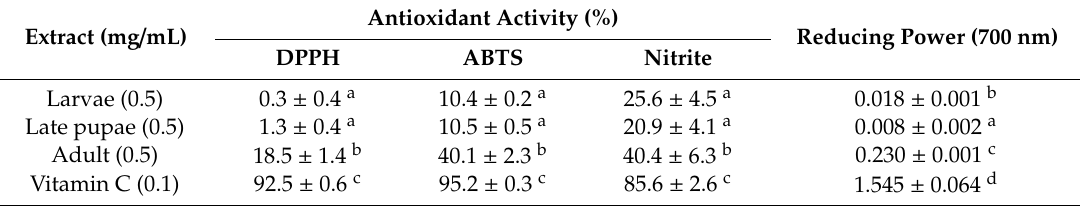
Table 4. Antioxidant activities of ethanol extracts of Buckfast honey bee drone larvae, pupae and adults from Denmark. The concentration used for 1,1-diphenyl-2-picryl hydrazyl (DPPH), 2,2-azobis (3-ethylbenzothiazoline-6-sulfonate (ABTS), and the reducing power assay was 500 µ g / mL and for the